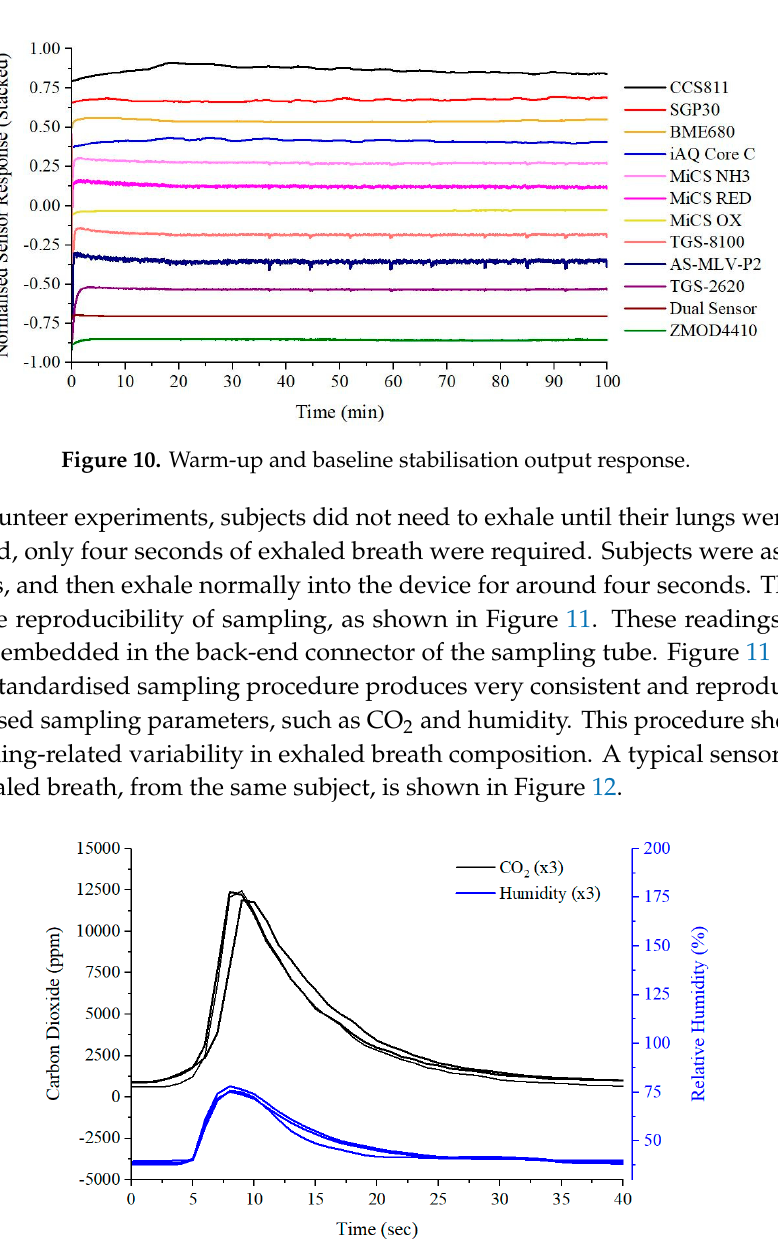
9 of 15 Figure 8. Testing of chemical standards; ( left ) PCA results; ( right ) Isobutylene concentration steps radar plot of normalised features. Figure 9. SGP30 and TGS-2620 gas sensor responses to increasing concentrations of isobutylene. 3.2. Volunteer Testing